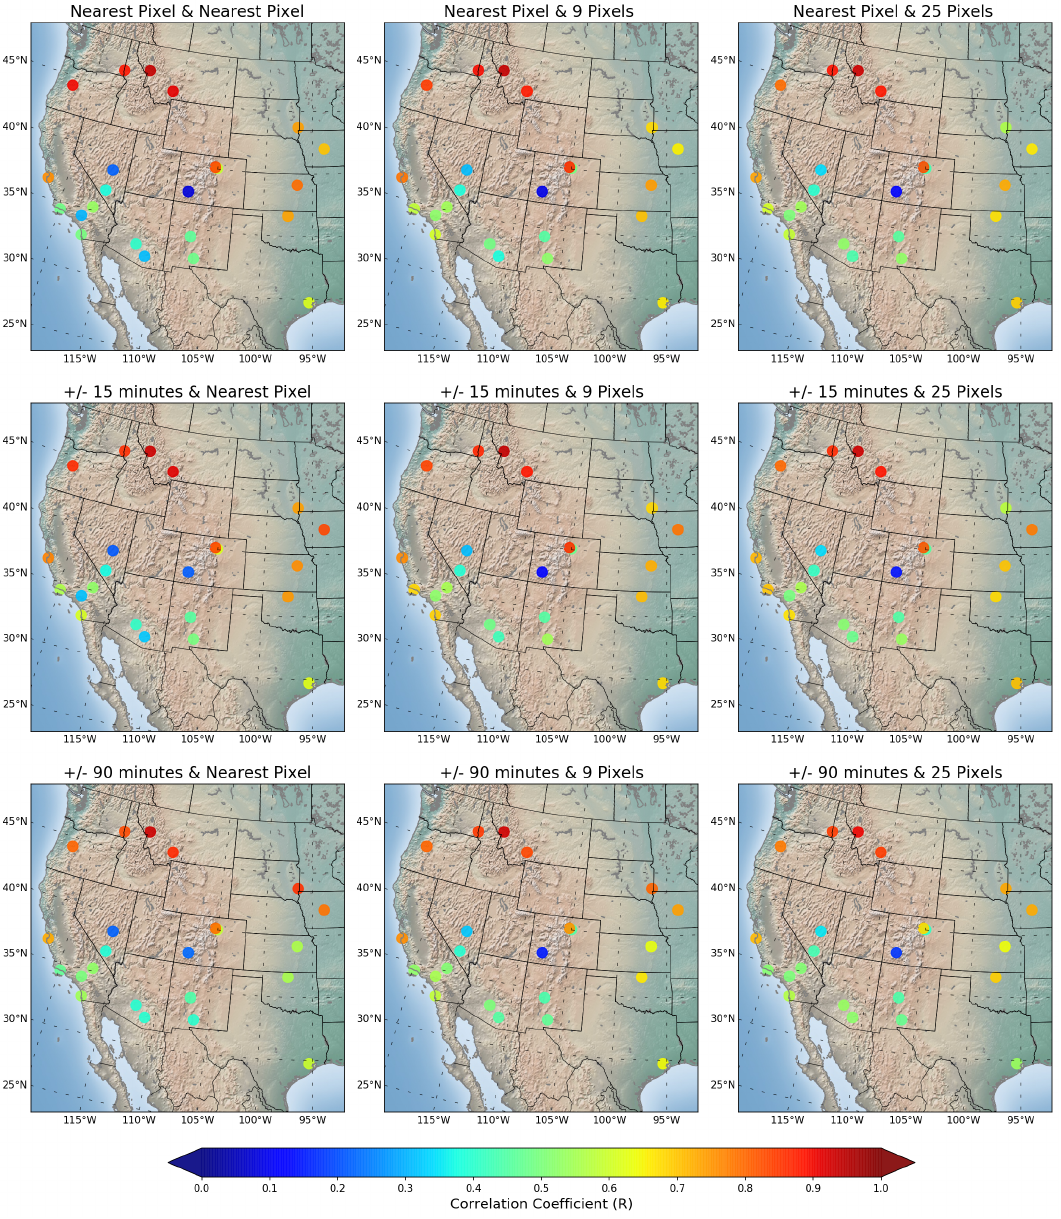
Figure 6. Pearson correlation coefficient between spatially aggregated at nearest pixel, 30 km × 30 km box and 50 km × 50 km box Aqua MODIS DB AOD and temporally aggregated at nearest, ± 15 min and ± 90 min AERONET AOD at 23 AERONET sites across the western United